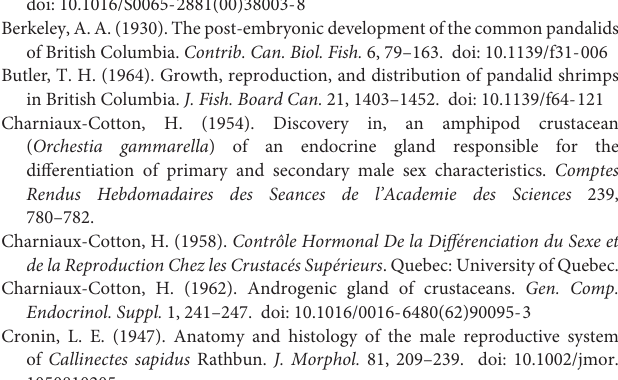
Supplementary Figure 1 | ‘Regenerative-looking pleopod.’ (A) Post-molt second pleopod of a male whose original second pleopod was removed in the beginning of the long term Pnp-IAG silencing experiment. (B) Post-molt second pleopod of a male whose original second pleopod was not removed in the beginning of the same experiment. Appendix interna and appendix masculina are indicated by yellow and black arrows, respectively. Bar scales (= 1500 µ m) are consistent in both photos. Supplementary Figure 2 | Heatmaps of the DE genes in the androgenic gland. The figure represents a larger version of the heatmap given in Figure 5 . Supplementary Figure 3 | Heatmaps of the DE genes in the eyestalk. The figure represents a larger version of the heatmap given in Figure 5 . Supplementary Figure 4 | Heatmaps of the DE genes in the gonad. The figure represents a larger version of the heatmap given in Figure 5 . Supplementary Figure 5 | Heatmaps of the DE genes in the hepatopancreas. The figure represents a larger version of the heatmap given in Figure 5 . Supplementary Table 1 | Differentially expressed (DE) transcripts between males and females in P. platyceros . DE transcripts ( P ≤ 0.05) from the transcriptomic library of P. platyceros (column A) and their read counts in each stage (male, transitional and female; columns B–G) are given in the excel file along with their linear fold change (column H), adjusted p -value (column I) and transcriptional pattern (down/up regulated; column J) between females and males. Blastp annotations are given in column K. Each sheet represents DE genes for a different tissue (Androgenic gland (AG), eye stalk (ES), gonad and hepatopancreas). Transcripts that were annotated as Pnp-IAG or Pnp-IAG -switch 1–6, in the AG data sheet, are marked in